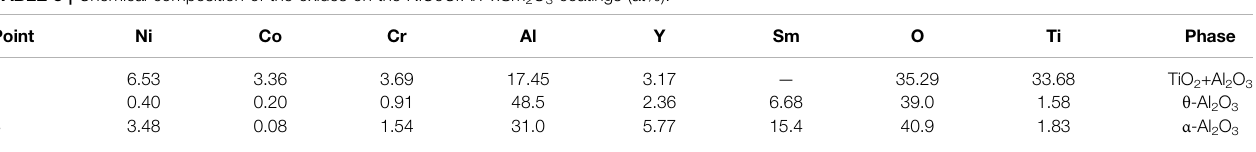
TABLE 3 | Chemical composition of the oxides on the NiCoCrAlY- x Sm 2 O 3 coatings (at%). Point Ni Co Cr Al Y Sm O Ti